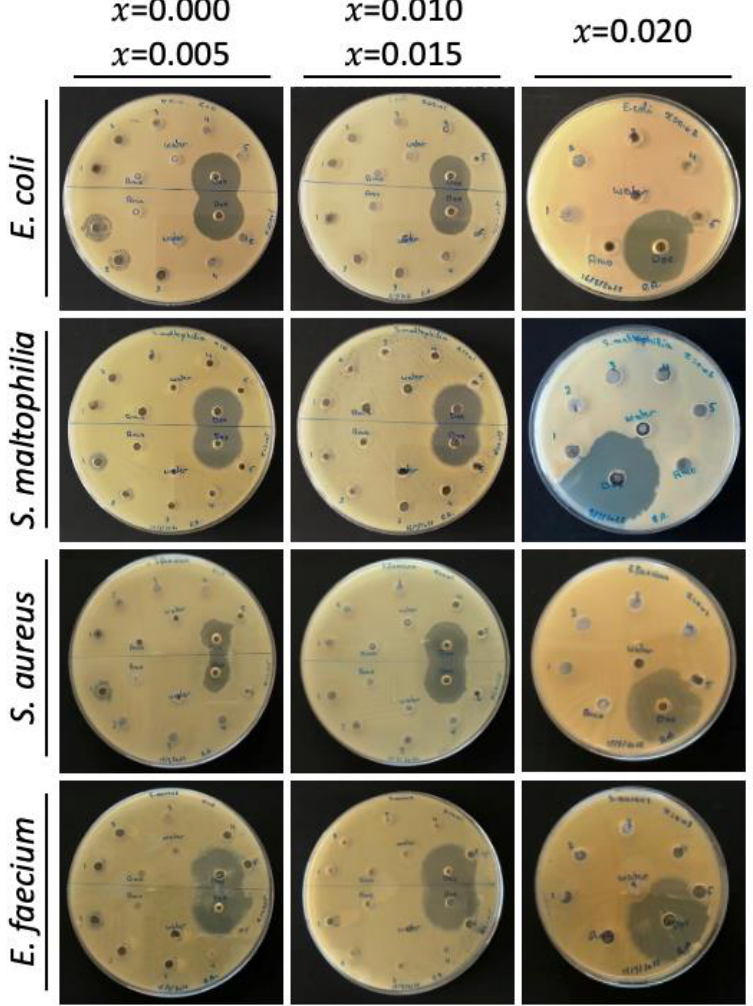
Figure A4. Agar well diffusion results of the undoped and Mg-doped CuO NPs against four bacterial isolates.